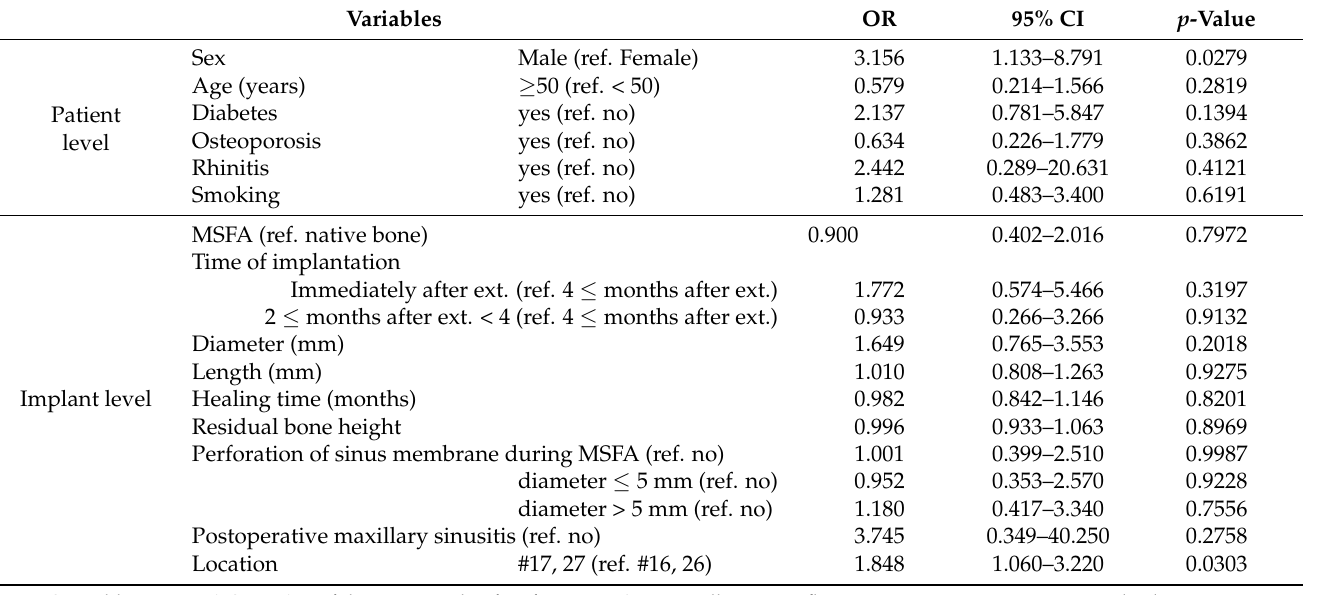
Table 4. Univariable analysis using generalized estimation equations (GEE) for marginal bone